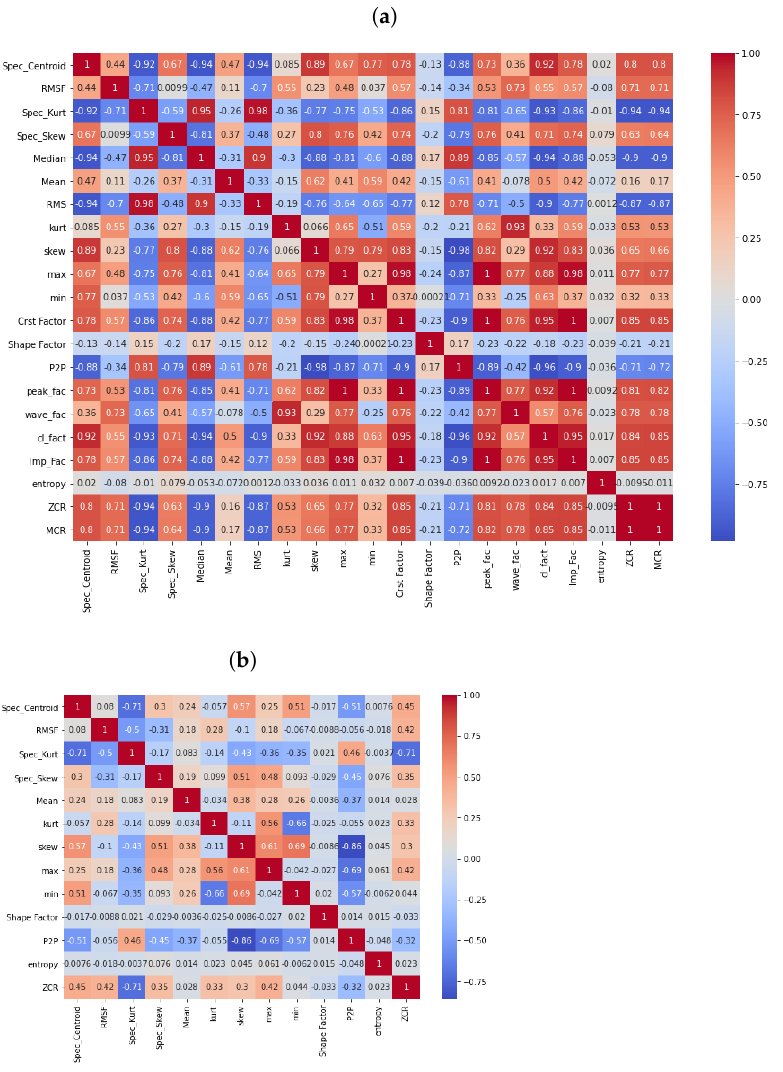
Figure 5. Correlation matrix of features: ( a ) all 21 features and ( b ) 13 uncorrelated features.